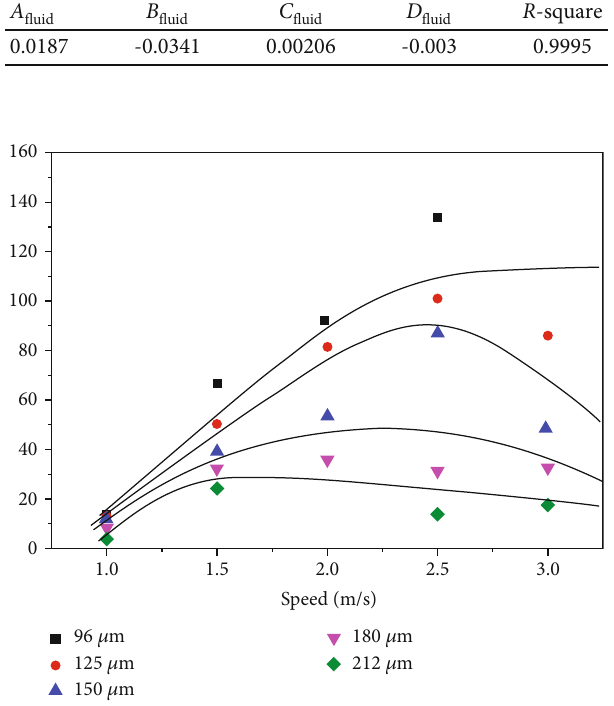
Figure 7: Correction coe ffi cient